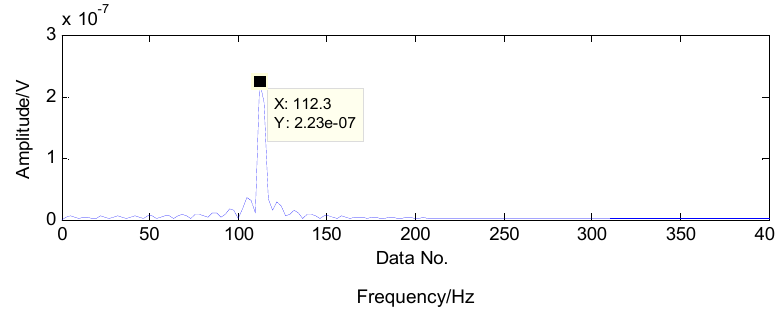
Figure 17. Second harmonic of the detected fault characteristic frequency through matching pursuit.